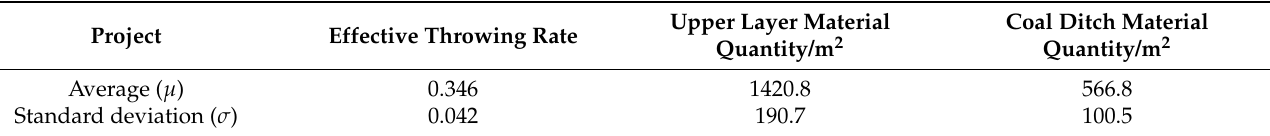
Table 6. Three basic indexes under the condition of 45 m blasting step height.